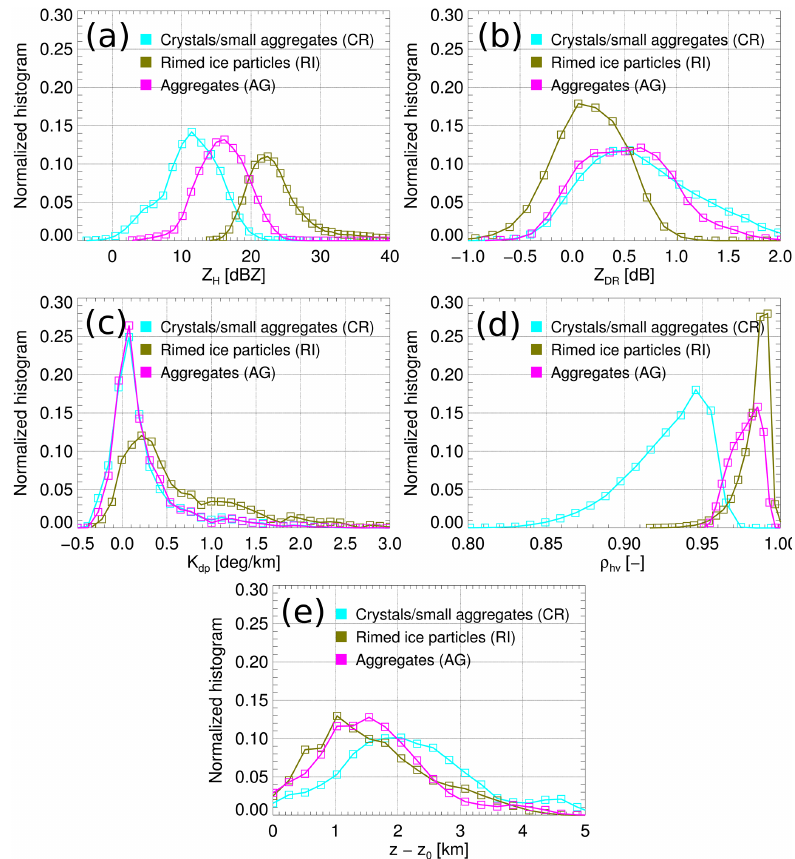
Figure 6. Distribution within the three clusters found at negative temperatures ( (cid:49)z > 0) of (a) Z H [dBZ], (b) Z DR [dB], (c) K dp [ ◦ km − 1 ], (d) ρ hv [–], and (e) (cid:49)z [km]. The curves are obtained considering the content of 100 runs of the clustering algorithm.